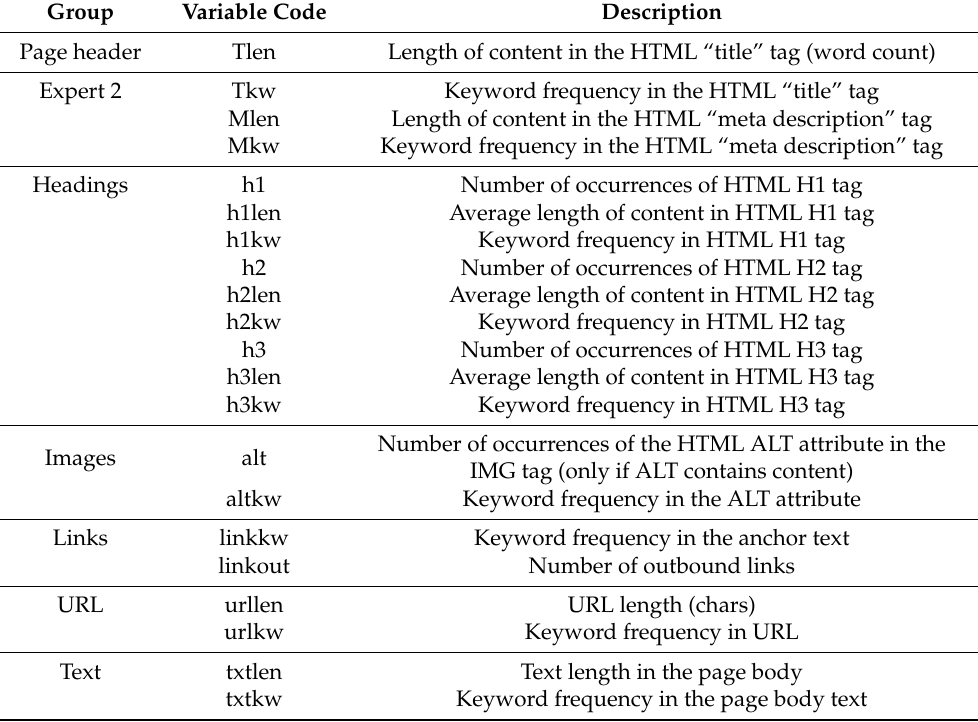
Table 5. List of independent variables used in this